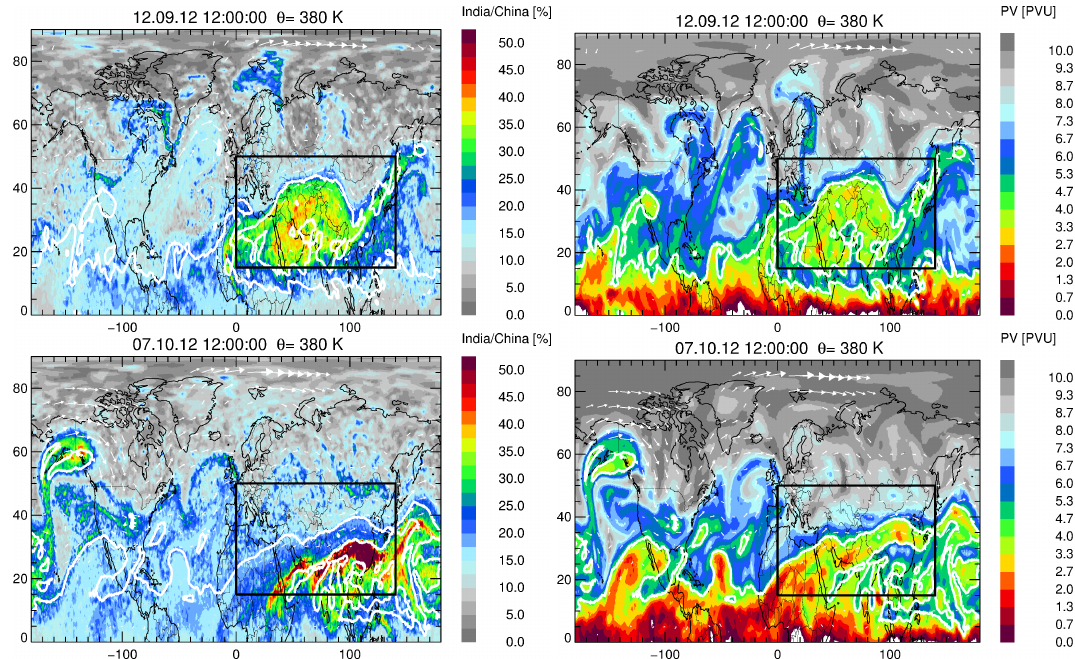
Figure 3. The same as Fig. 2 but on 12 September 2012 (top) during the late phase of the anticyclone and on 7 October 2012 (bottom) showing the distribution of emission tracers for India/China after the breakup of the anticyclone.